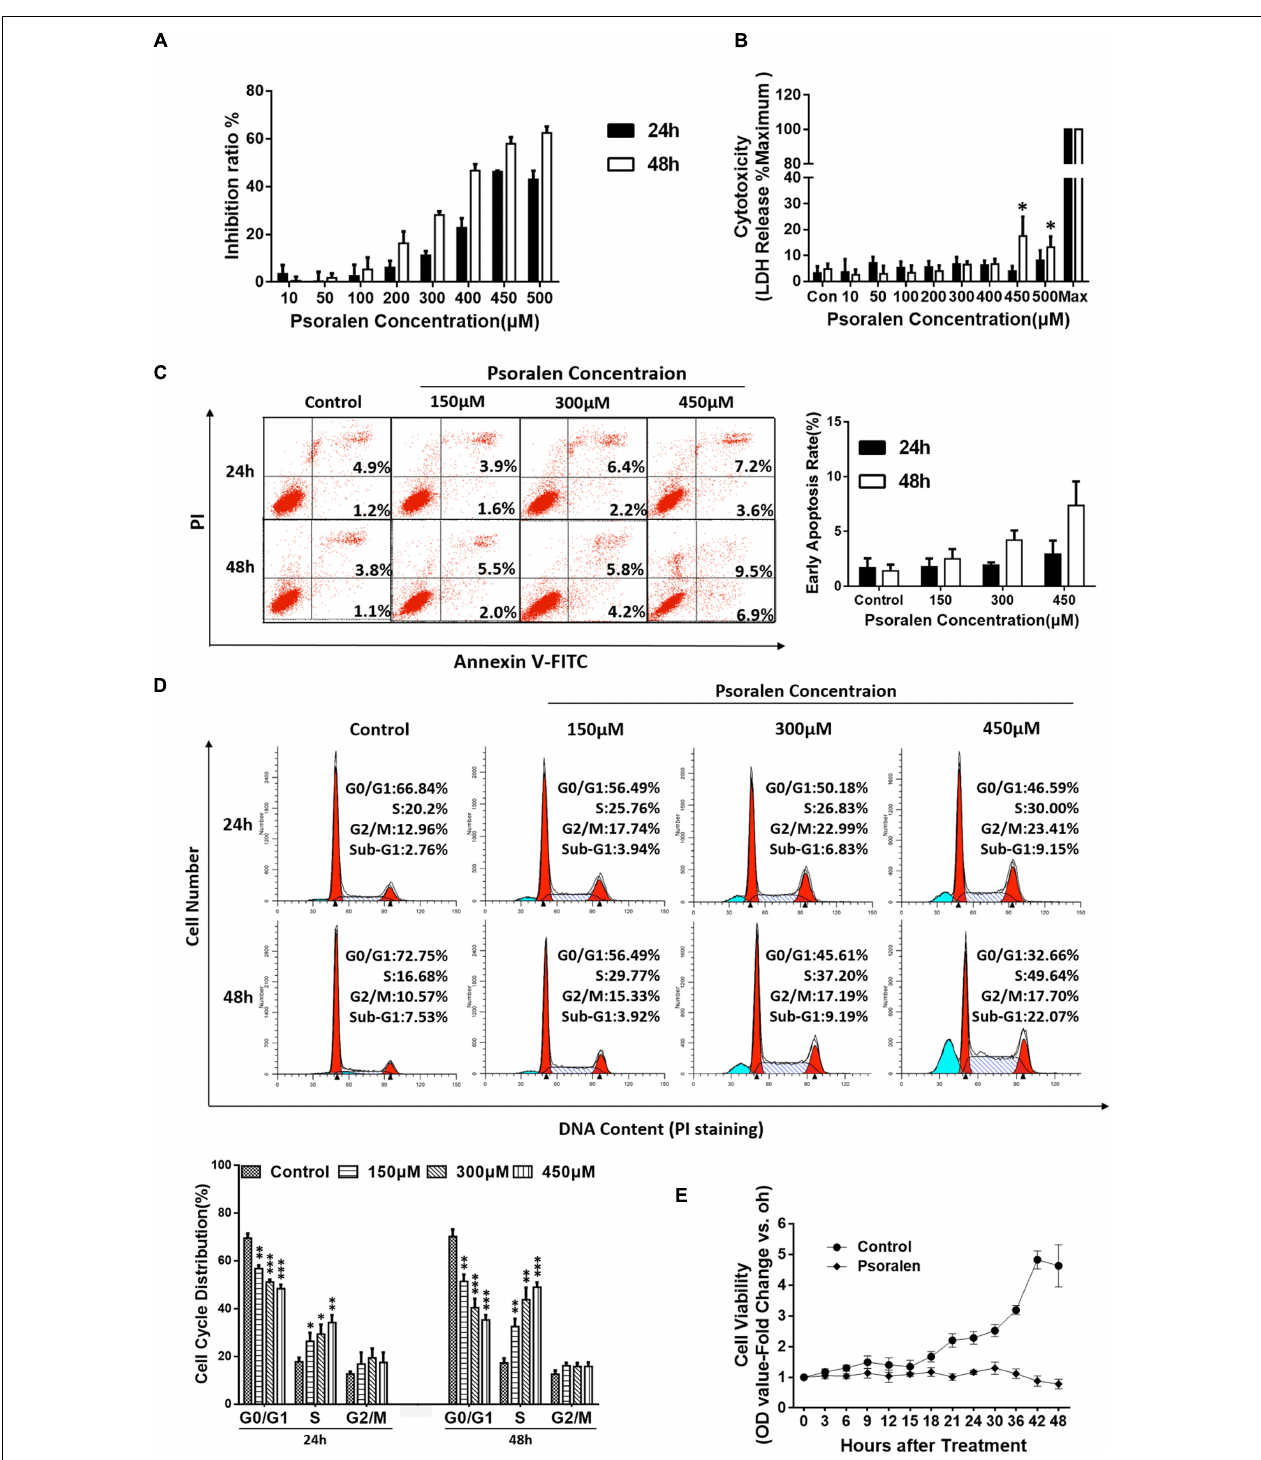
FIGURE 2 | Psoralen inhibited the viability of L02 cells by inducing S-phase arrest. L02 cells were treated with DMSO or psoralen. (A) MTT assay was used to determine L02 cell viability. (B) LDH release assay was used to evaluate the cell membrane integrity. (C) Apoptotic analyses were performed using Annexin V-FITC/PI double staining. Left panel: representative results of flow cytometry analysis; right panel: quantitative statistics of early apoptotic cells. (D) Cell cycle analysis using PI staining. Upper panel: representative results of flow cytometry analysis; lower panel: quantitative statistics of cell cycle distribution. (E) MTT assay was used to monitor cell proliferation. All experiments were performed three times independently and the quantitative data are shown as the means ± SDs. ∗ p < 0.05, ∗∗ p < 0.01, ∗∗∗ p < 0.001 versus control group.